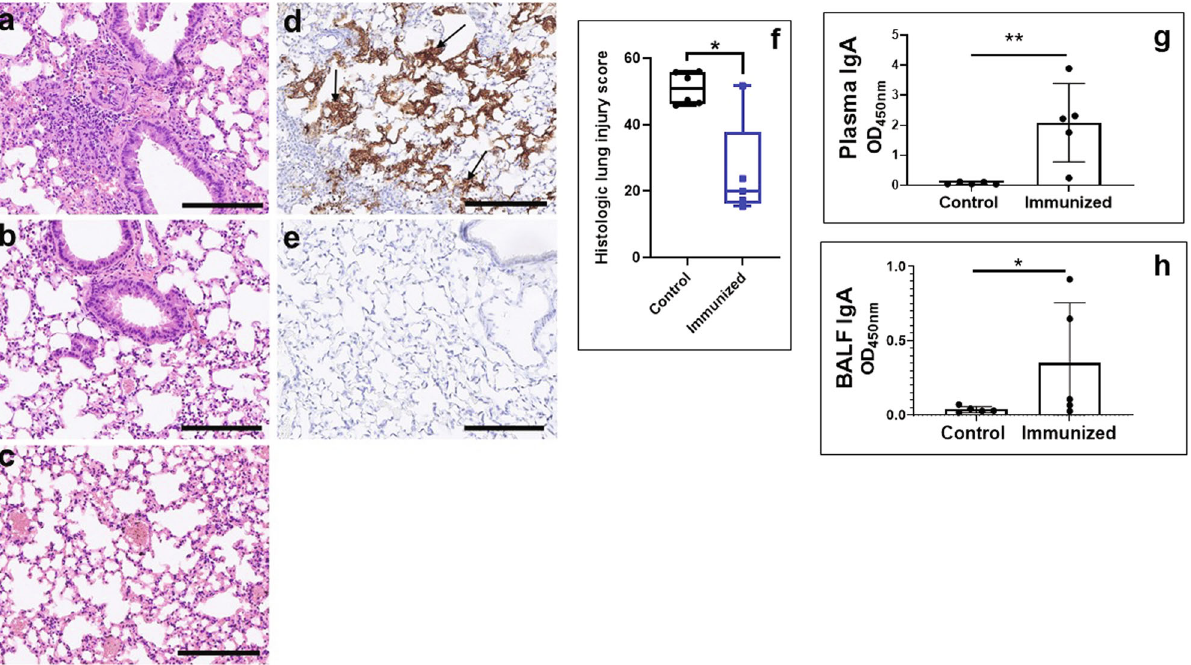
Fig. 2 Two immunizations were suf fi cient to protect mice from lung pathology and elicited a robust IgA response. K18-hACE2 mice were immunized with adjuvanted Spike vaccine using a subcutaneous prime (day-0) and intranasal boost (day-21). Mice were challenged 2-weeks postsecond immunization and lungs were sampled on the day of the maximal clinical score (day-6) requiring animal euthanasia in the control group, an equal number of vaccinated mice were also euthanized. Representative H & E stained histology sections: Control mice ( a ) showed severe lung injury with marked in fi ltration of immune cells whereas immunized mice ( b ) showed attenuated lung injury closer to lung histology in a normal mouse ( c ). Immunohistochemistry: Lungs were stained with SARS-CoV-2 antinucleocapsid antibodies. Control mice ( d ) showed presence of virus (arrows) whereas vaccinated mice ( e ) showed clear lungs. Lung injury score. Histology sections were scored in a blinded manner ( f ). IgA ELISAs: Plasma ( g ) and bronchoalveolar lavage fl uid ( h ) samples were harvested a week after the second immunization and anti-S1 response was tested using ELISA. Boxes denote mean with standard deviation. Scale bar = 100 μ m. Asterisks indicate that the results are statistically signi fi cant as follows: * p < 0.05; ** p <